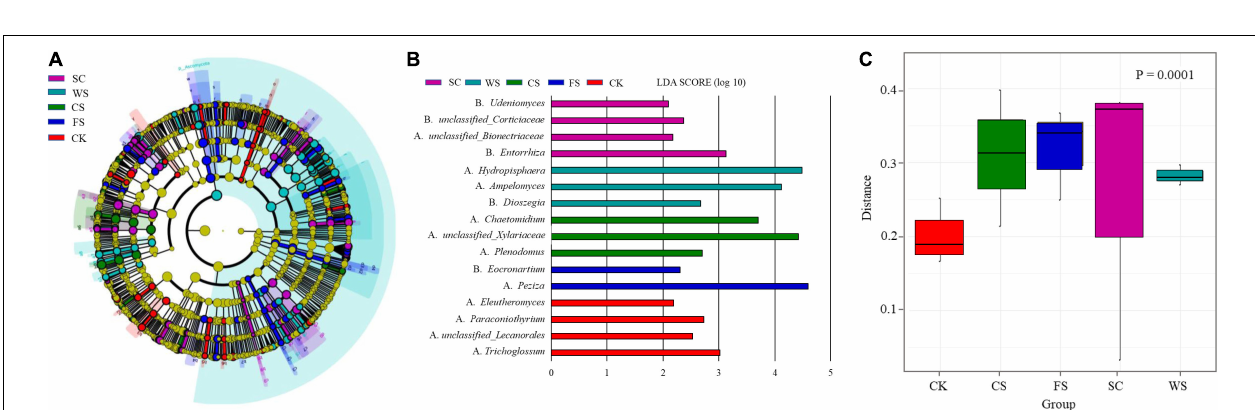
FIGURE 4 | Analysis of species and community functions of fungi with significant differences in soil under different cropping systems. Different color areas represent different groups. (A) Taxonomic cladogram produced from LEfSe. The phylum, class, order, family, and genus levels are listed in order from inside to outside of the cladogram. LEfSe diagram. The corresponding color nodes in the diagram represent the groups that play an important role in this grouping (significantly different from other groups), and the yellow nodes represent the microbial groups that do not play an important role. (B) Shows the species with significant differences in abundance in different groups, and the length of the histogram represents the influence degree of the species with significant differences. (C) The UniFrac distance matrix was used to draw the distance diagram between sample groups. The ordinate represents the sample weighted UniFrac distance, and the p -value in the upper right corner represents the test results of the difference between groups.